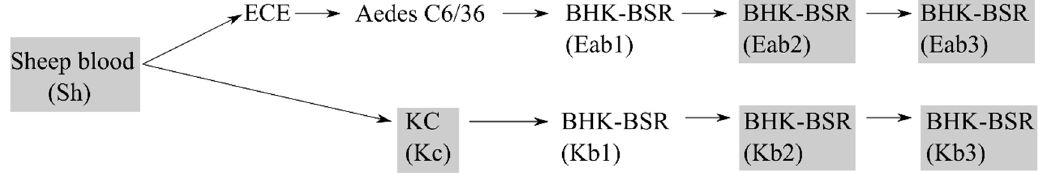
Figure 1. Passage history of the bluetongue viruses used in this study. The virus passages studied are in gray boxes and designated virus names are in brackets.